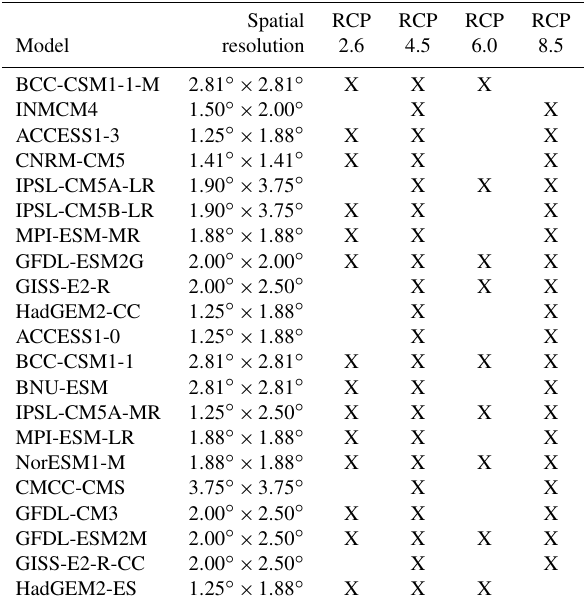
Table 3. CMIP5 climate models used for the Terskol climate pro- jections (2019–2100CE).